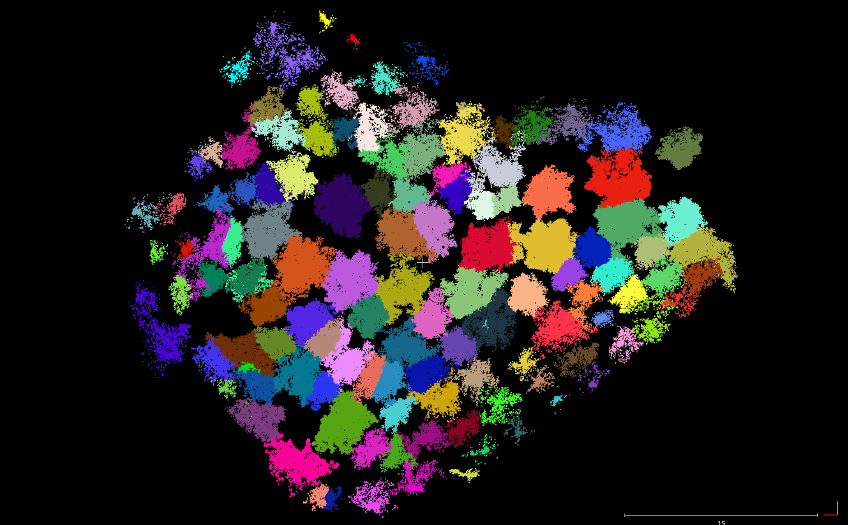
Figure 13. Zoom screenshot at the segmented point cloud.